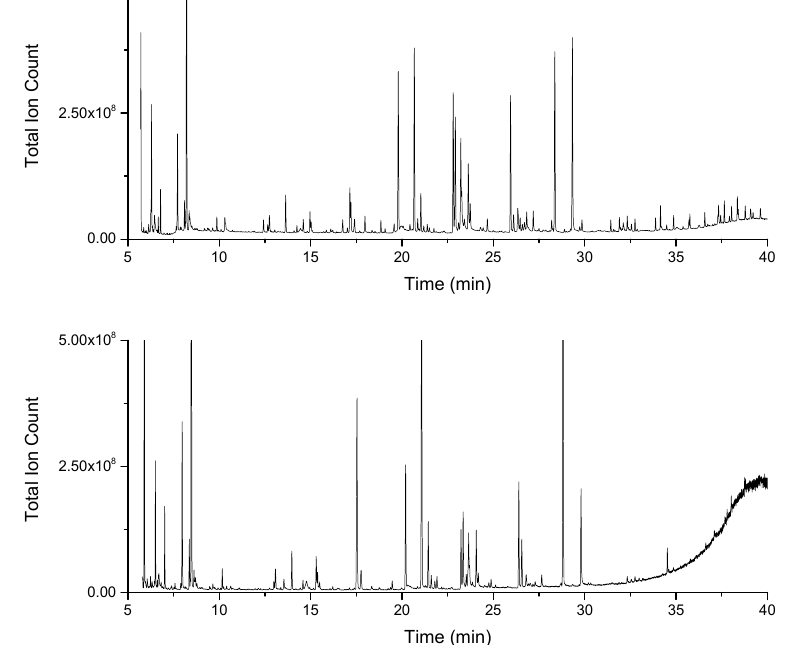
Figure 2. Chromatograms of pooled samples of the salt stress experiment. Chromatograms show SSkeletonema costatum extracts measured on the ISQ GC–MS (top) and on the Orbitrap GC–MS (bottom). Orbitrap data were recorded with a split ratio of 1:50 and a concentration equivalent to 5 × 10 4 cells per µL of sample, GC-ISQ data with a split ratio of 1:50 and a concentration equivalent to 4 × 10 5 cells per µL of sample.